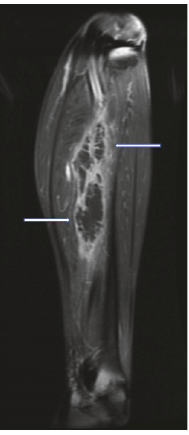
Figure 5: T2 weighted, fat saturated, postcontrast, coronal MR image of left calf showing a multiloculated fluid collection with associated enhancing rim and septations (white arrows) within the tibialis posterior muscle, compatible with an intramuscular